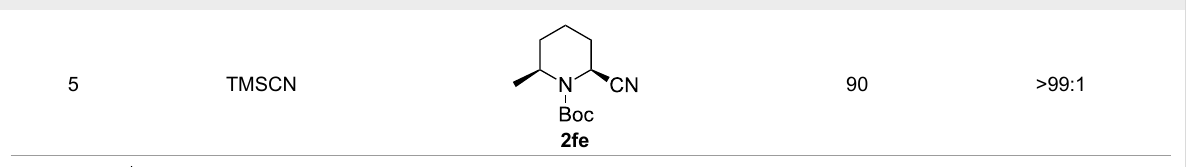
Table 6: Reaction of N- acyliminium ion C6 with several nucleophiles. (continued)